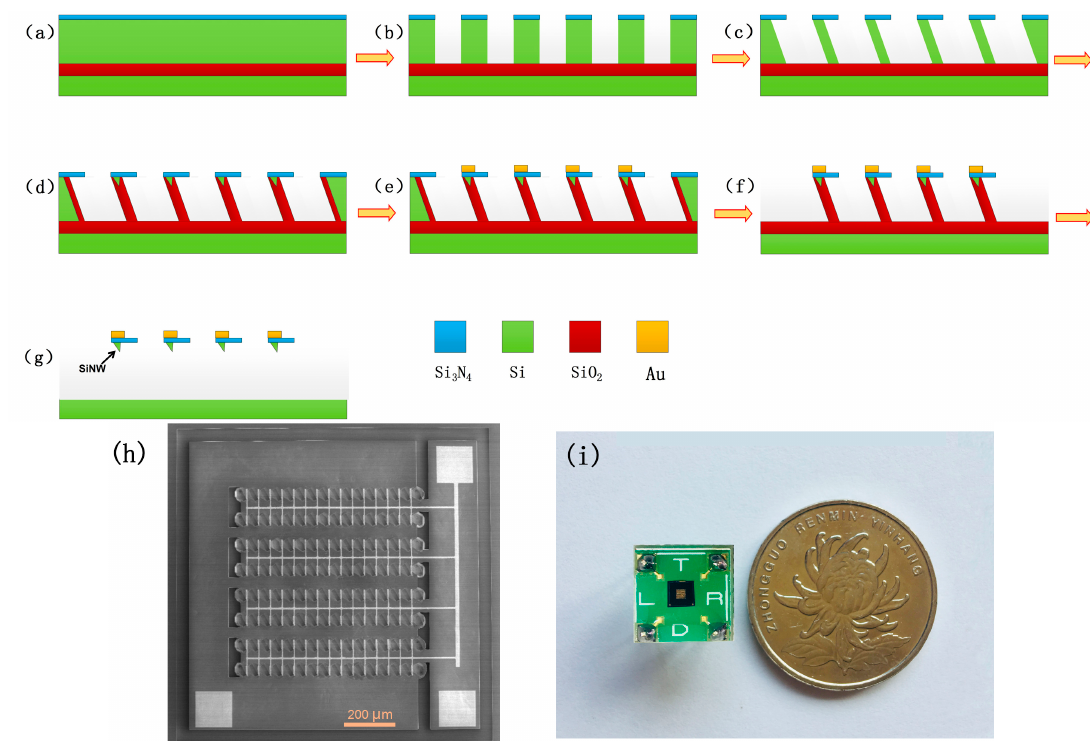
Figure 1. The fabrication process of the silicon nanowires (SiNW) array device. ( a ) The silicon nitride was deposited on a (111) silicon-on-insulator (SOI) wafer. ( b ) The reaction ion etching to form etched cavities. ( c ) The anisotropic wet-etching to form silicon walls between the adjacent etched cavities. ( d ) The self-limiting oxidation to form SiNWs. ( e ) The fabrication of source electrode, drain electrode and top-grid electrode. ( f ) The fabrication of the trench isolation. ( g ) Removing the silica walls. ( h ) The scanning electron microscope (SEM) photograph of the SiNW array device. ( i ) The photo of the packaged SiNW array device.